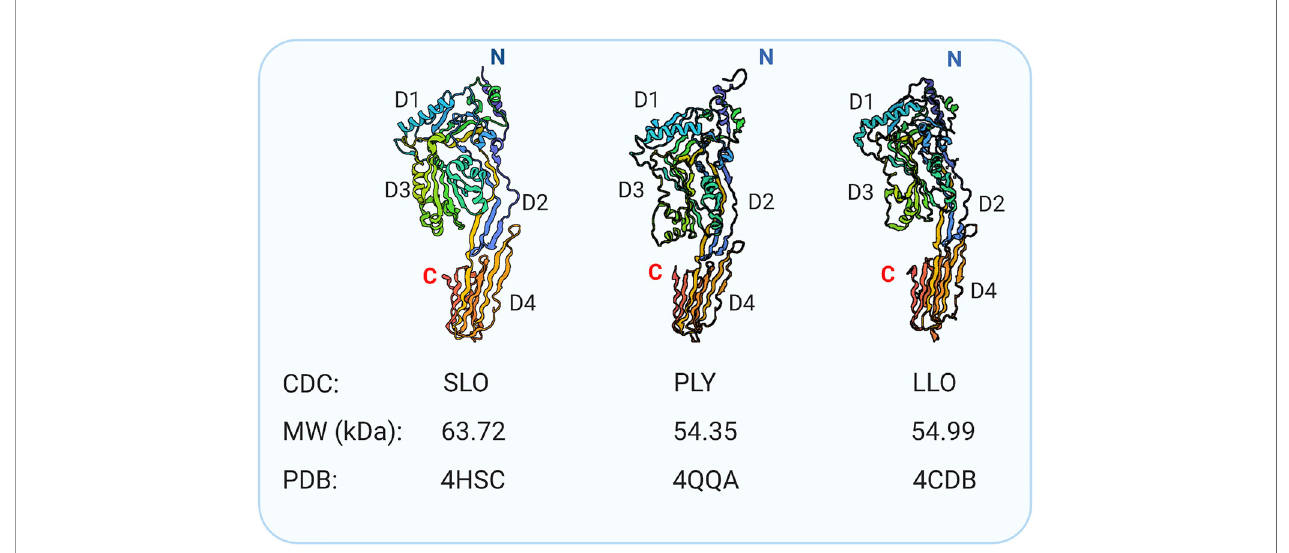
FIGURE 1 | Bacterial pore-forming cholesterol-dependent cytolysins used in mast cell research. Crystal structure of SLO (42), PLY (49), and listeriolysin (LLO) (50). Indicated are N-terminus, C-terminus, and four domains rich in b -sheets: Domain 1 (D1), Domain 2 (D2), Domain 3 (D3) with the transmembrane spanning region, and Domain 4 (D4) involved in the initial direct interaction with cholesterol and glycans (51 – 53). The molecular weights and protein data bank (PDB) codes are also